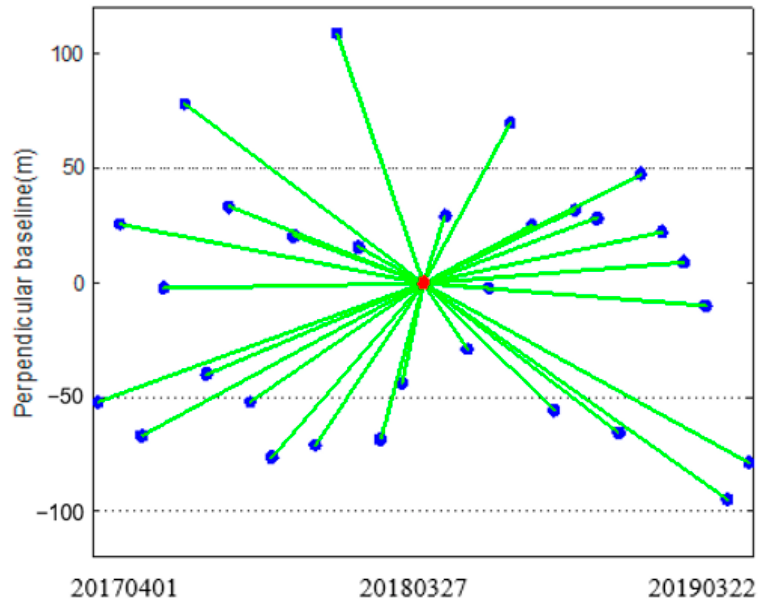
Figure 8. The baseline configuration of the used data set.